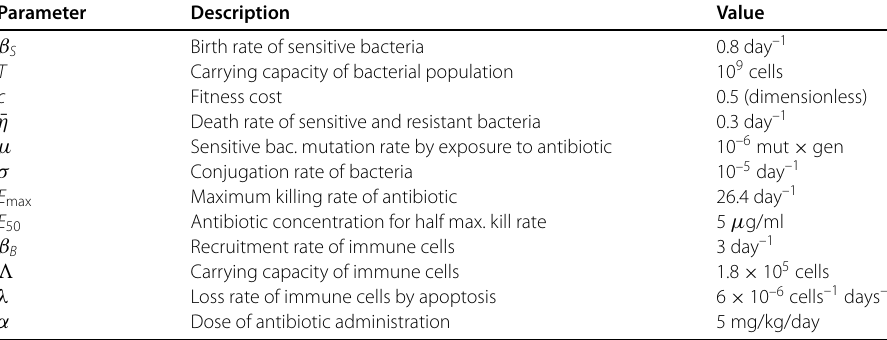
Table 1 Descriptions and values of the